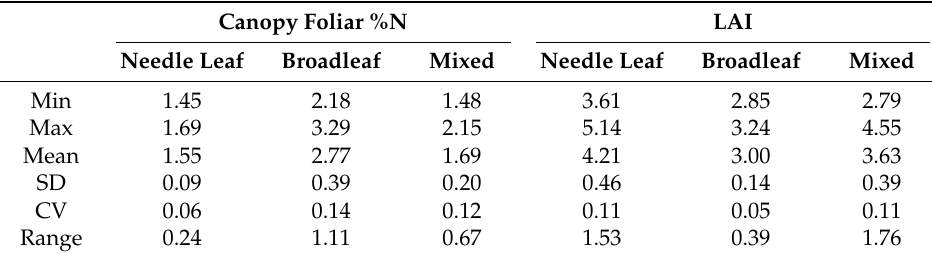
Table 2. Statistics of in situ canopy foliar %N and LAI (plot number = 26).